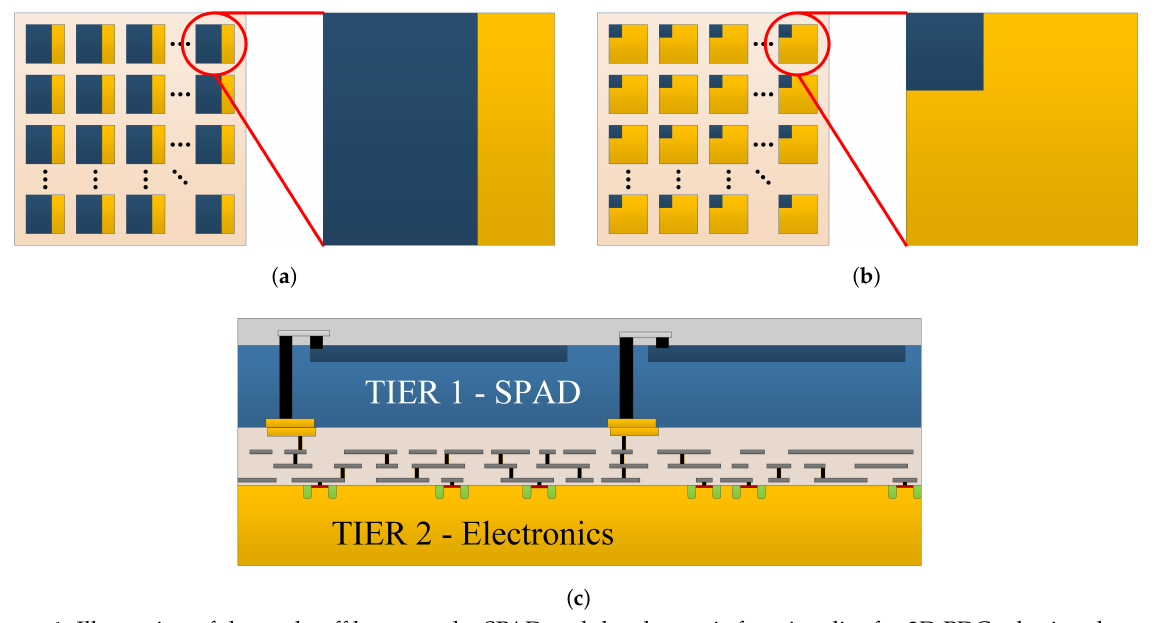
Figure 4. Illustration of the trade-off between the SPAD and the electronic functionality for 2D PDCs sharing the same technology node compared to a 3D PDC. In ( a ), a 2D PDC with large SPAD (blue), but limited in-pixel electronics functionalities (yellow). In ( b ), a 2D PDC with small SPAD (blue), but greater in-pixel electronic functionalities (yellow). In ( c ), a 3D PDC with large SPAD (blue) and large area for in-pixel electronic functionality